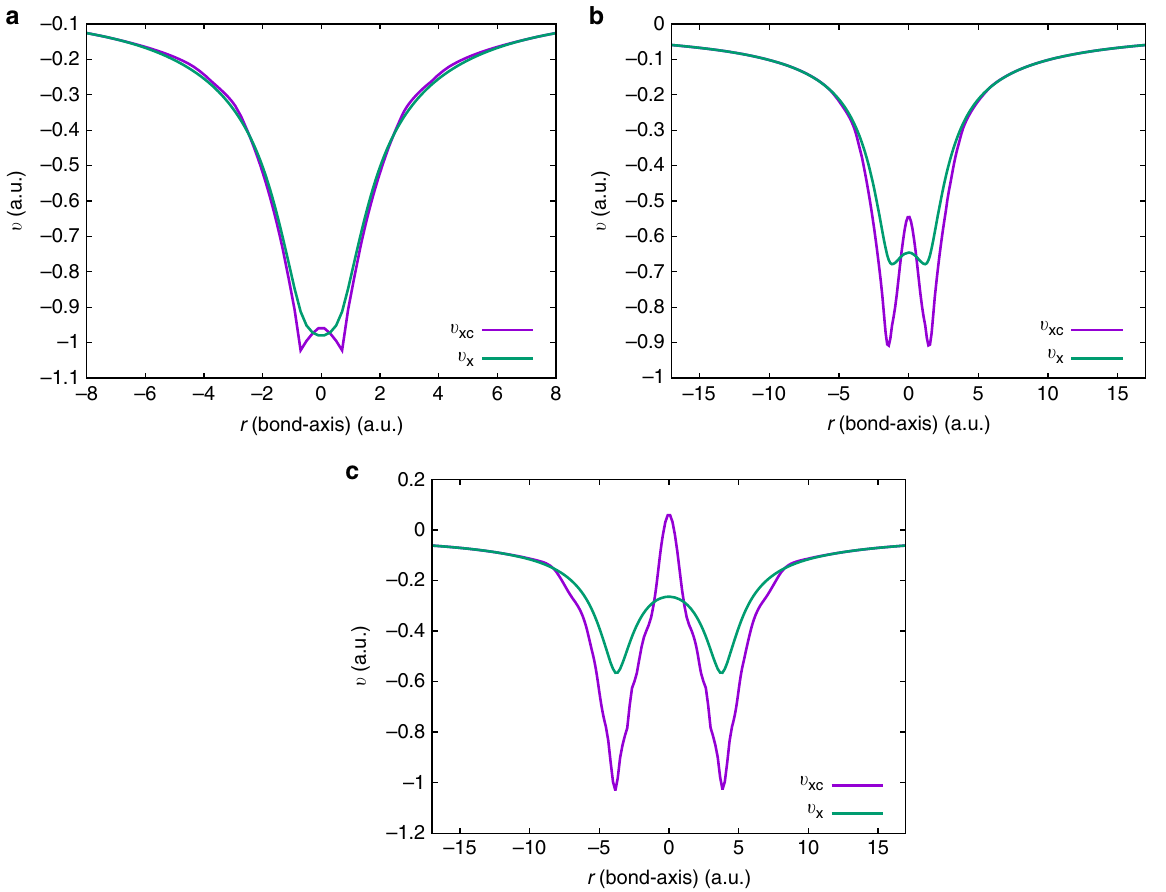
) and the exchange-only ( v x ) xc and v indicates the nature and extent of electronic correlations. The correlations xc x